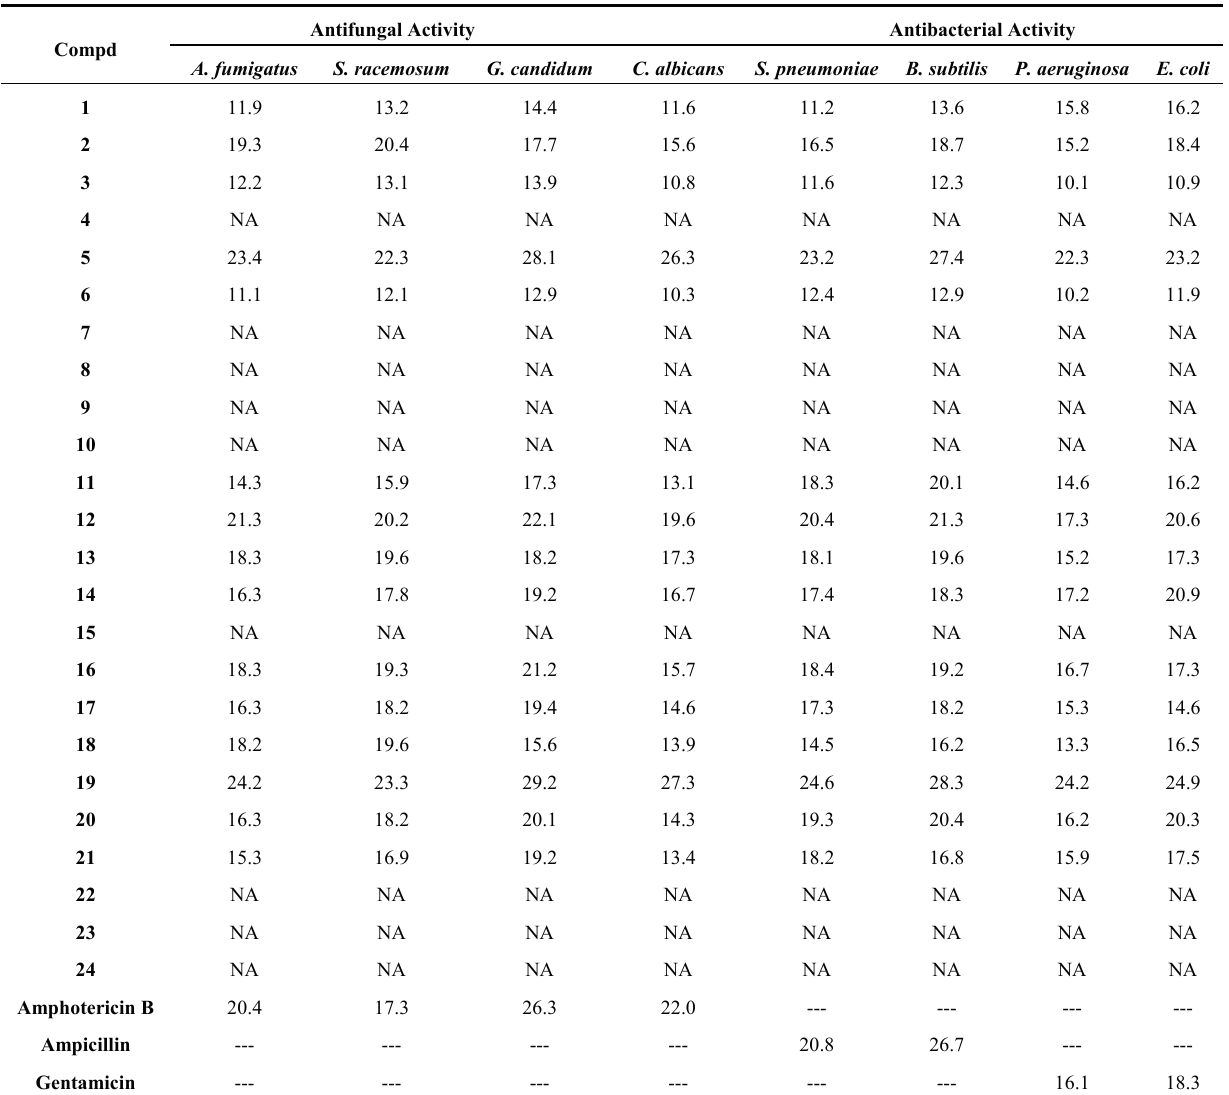
Table 2. Antimicrobial activities (inhibition zone; diameter in mm) of ILs 1 – 24 against four fungi and four